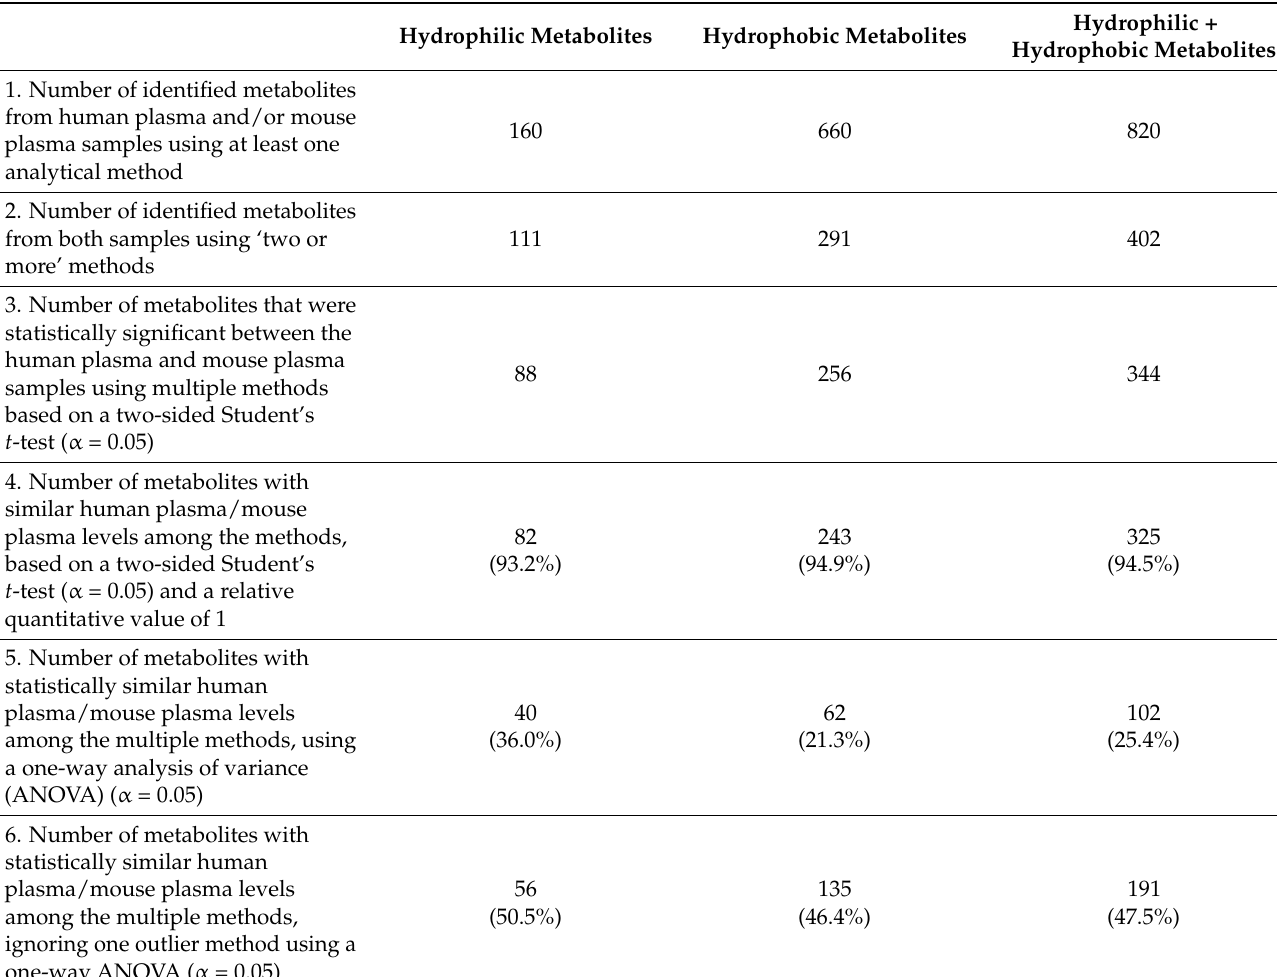
Table 3. Summary of